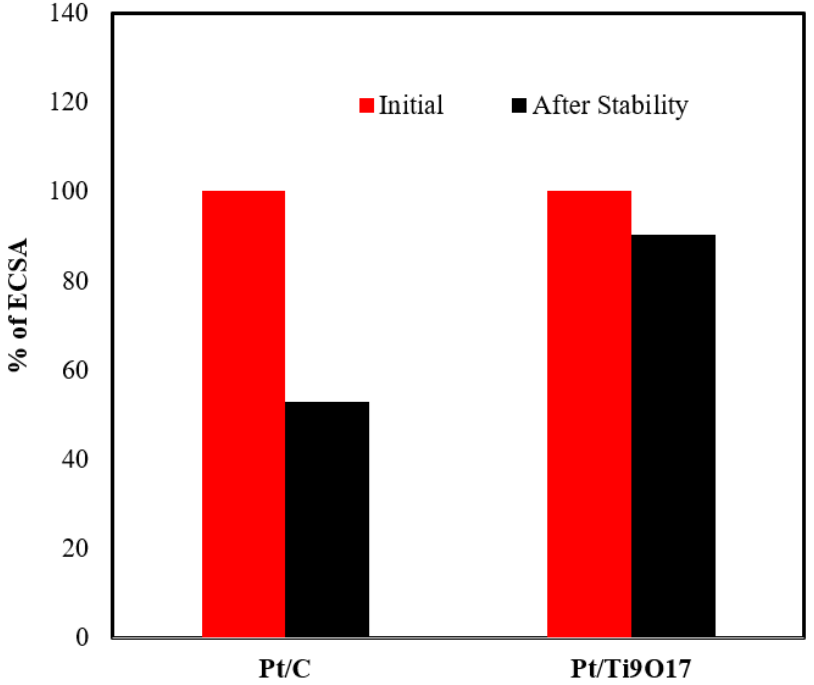
Figure 6. The ECSA before and after stability for state-of-the-art Pt/C catalyst and Pt/Ti 9 O 17 catalyst.